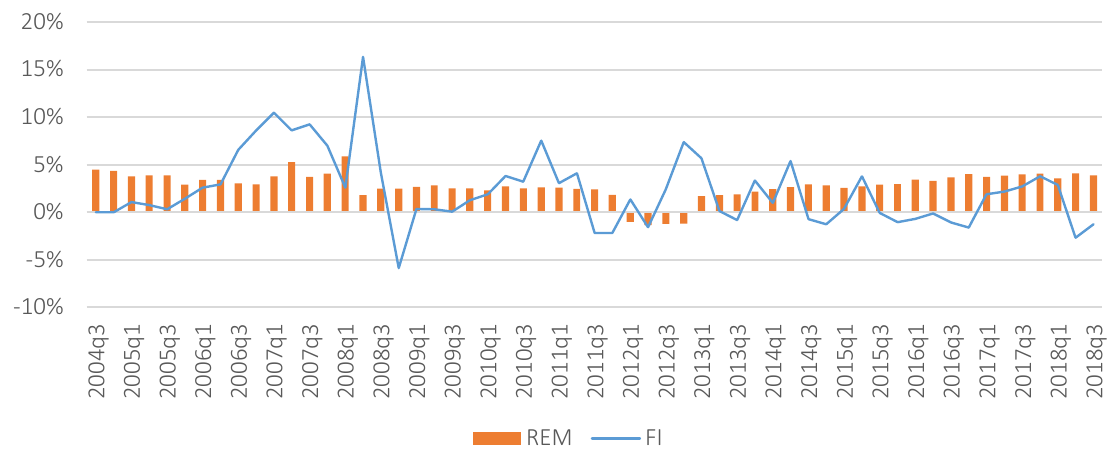
Figure 5. Real estate market (REM) and net trading value by foreign investors